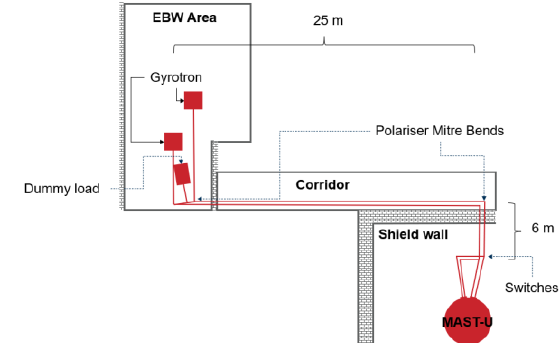
Fig. 2. Illustrative layout of the transmission line showing key components (top view)